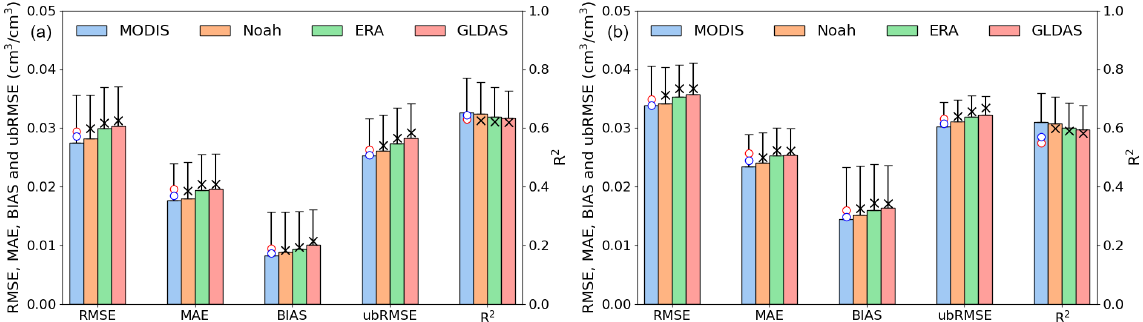
Figure 12. Metrics of models using different DTRs for (a) NC and (b) SC. Error bars denote 1 σ errors. The “x” symbol represents the accuracy metrics of the models without the DTR correction procedure. The “o” symbol in red represents the accuracy metrics of the models using GLEAM SM to replace ERA SM, and the “o” symbol in blue represents the accuracy of the models using Noah SM to replace ERA SM.